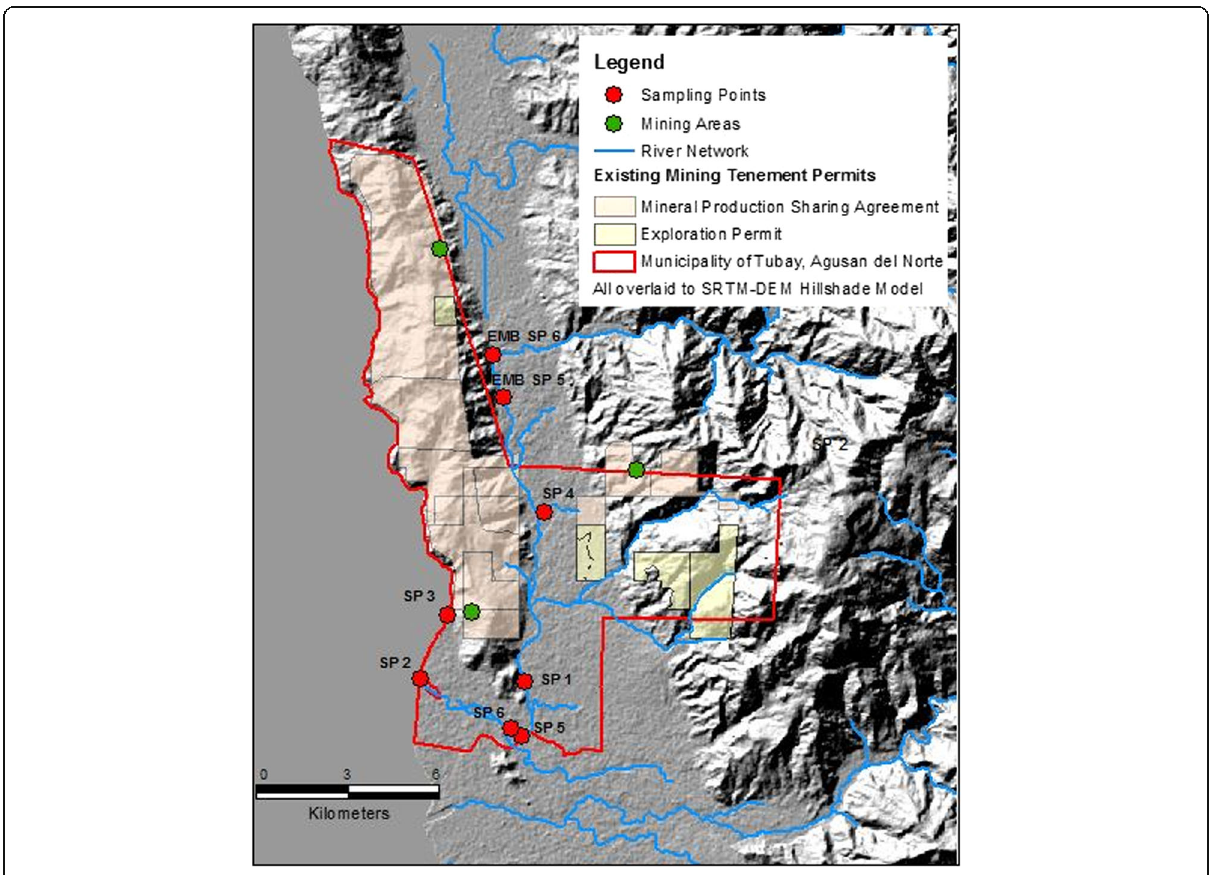
Fig. 1 The study area showing the Municipality of Tubay, the area coverage of approved mining permits, the location of the existing mining sites, and the sampling